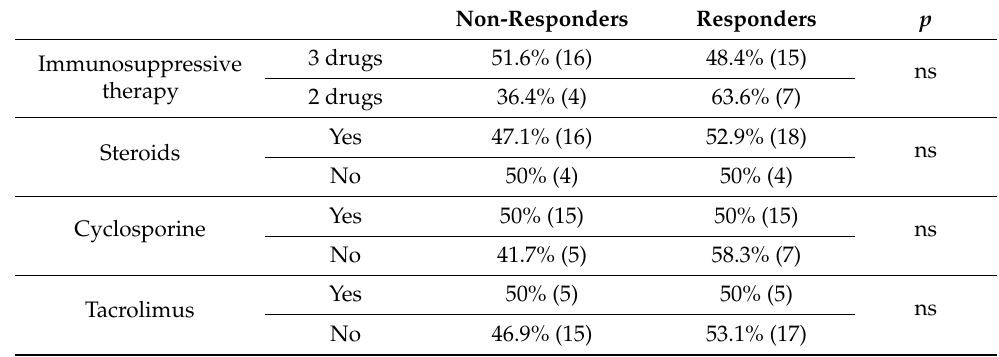
Table 3. Immunosuppressive therapy and vaccine